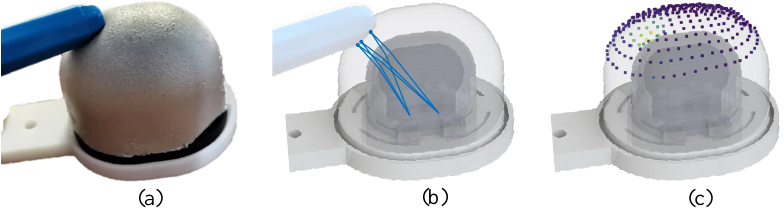
Figure 1. Diagram of tactile 3D reconstruction based on ray tracing: ( a ) real GelStereo-type sensor contacted with a pen; ( b ) ray-tracing diagram (the blue lines indicate light ray paths inside the sensor undergoing multi-medium refraction); ( c ) reconstructed 3D point cloud (the points in light color denote the contact